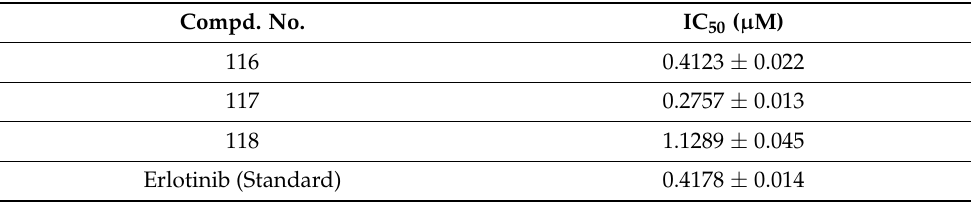
Table 4. The inhibitory activities of 1,3,4-oxadiazol acetamide moiety containing6,7-disubstituted quinoline derivatives against